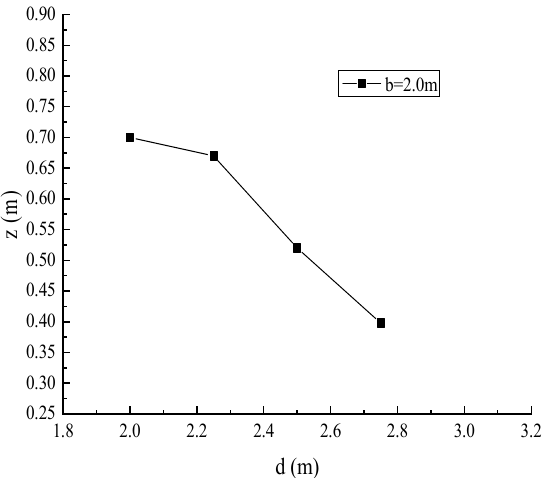
Figure 9. Influence of foundation burial depth on safe depth.